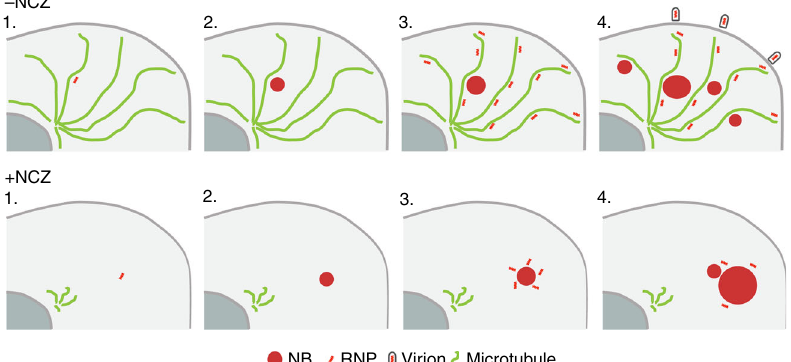
Fig. 7 A model for the dynamics of RNPs and NBs in RABV infected cells treated (+NCZ) or not ( − NCZ) by Nocodazole. 1. and 2. The initial NB is formed around an incoming RNP. 3. RNPs are ejected from NB by a process which is microtubule independent and are transported away from the initial NB along the microtubule network ( − NCZ) or remain in the vicinity of the initial NB when the cells are treated by Nocodazole (+NCZ). 4. In untreated cells ( – NCZ), the newly formed RNPs can give rise either to new virions upon budding at the cell membrane or to new viral factories which form NBs of intermediate size. In Nocodazole-treated cells (+NCZ), the newly formed viral factories are located in the vicinity and rapidly fuse with the initial NB which then becomes